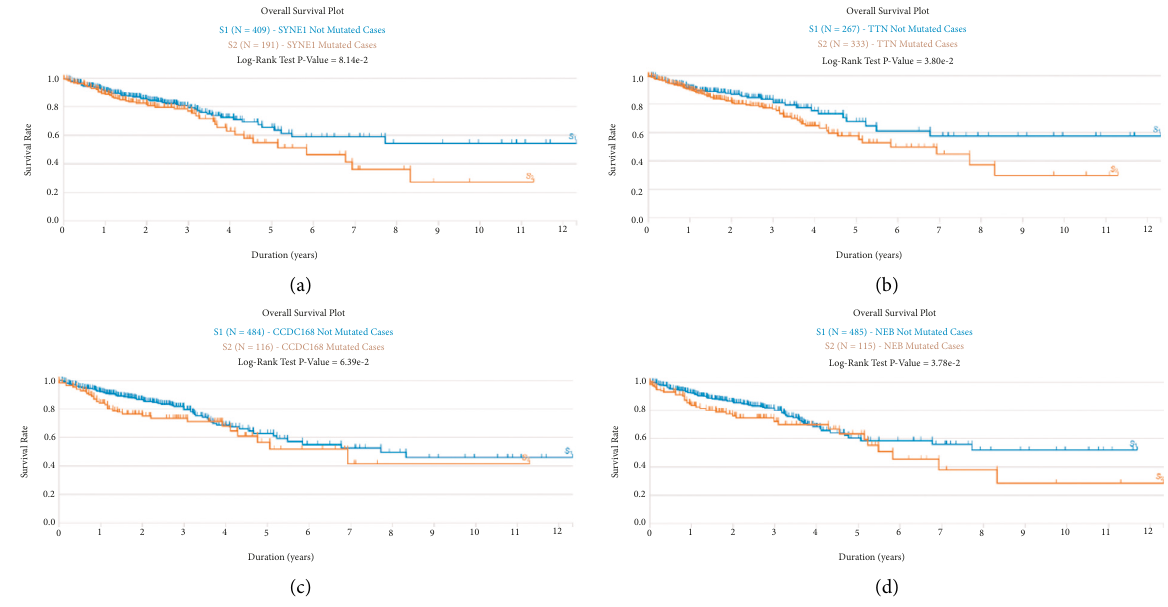
Figure 2: Identification of survival-associated somatic mutated genes. The CRC patients with SYNE1 (a), TNN (b), CCDC168 (c), and NEN (d) mutations had a shorter overall survival